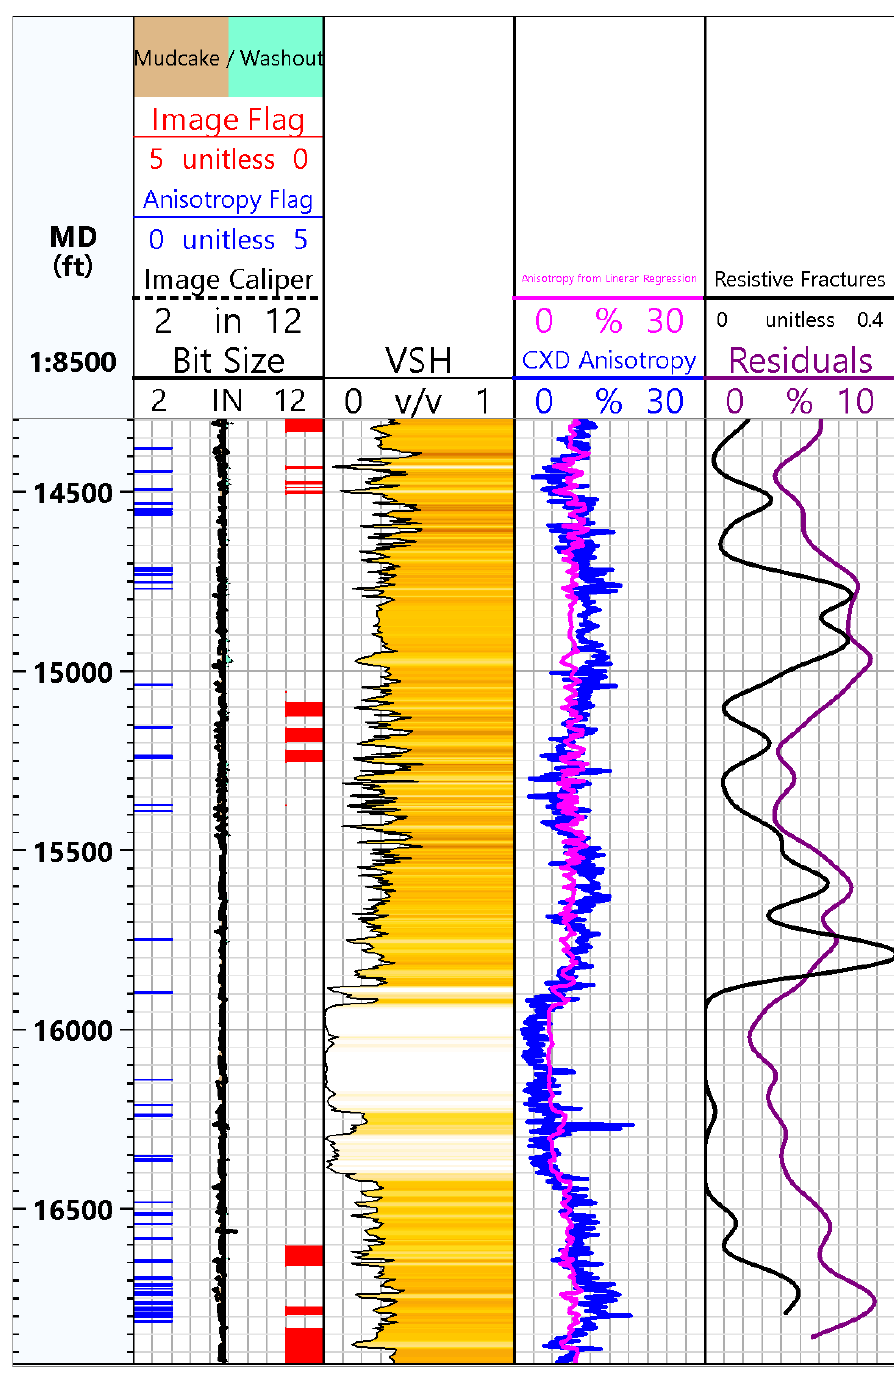
Figure 11. Well logs from the validation well showing a strong correlation between the cross-dipole sonic anisotropy (CXD) and the anisotropy predicted using Equation (5), and a strong correlation between the residuals and resistive fracture frequency when smoothed with a 100 ft Gaussian operator. The first track to the right of depth displays the caliper data colored by the mud cake (tan)/washout (aquamarine), along with the image quality flags (red) and acoustic quality flags (blue). The black curve, in the third track, is the volume of shale (VSH) log showing obvious lithological variability colored by VSH values, with lower values in the lighter colors (carbonates) and higher values in the darker colors (shales). The blue curve, in the fourth track, is the dipole acoustic anisotropy. The pink curve, in the fourth track, is the predicted anisotropy using Equation (6). The fifth track contains the calculated residuals in purple and the resistive fracture frequency in black.